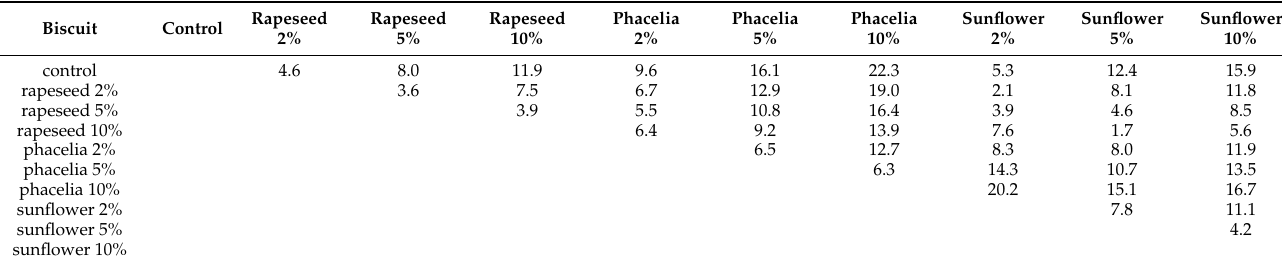
Table 5. Colour difference ( ∆ E ab* ) values of